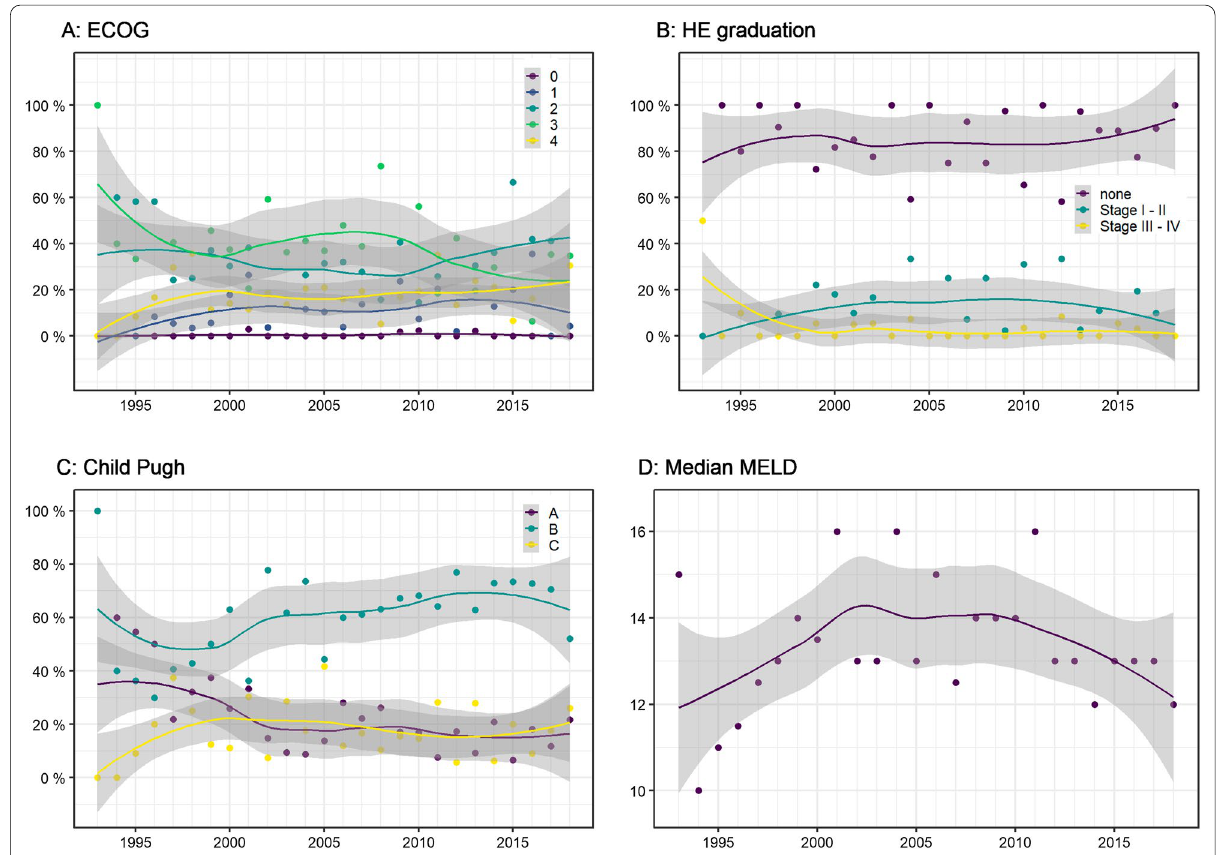
Fig. 4 Clinical and laboratory parameters. a Eastern Cooperative Oncology Group (ECOG) score. Proportion of patients classified according to ECOG score during the observation period. ECOG: 0—asymptomatic, 1—symptomatic but completely ambulatory, 2—symptomatic, < 50% in bed during the day, 3—symptomatic, > 50% in bed, but not bedbound, 4—bedbound, 5—death [45]. b Hepatic encephalopathy before TIPS. Proportion of patients with HE classified according to the West Haven Criteria over the observation period. I: mild symptoms, e.g., loss of sleep and shortened attention span. II: moderate symptoms, e.g., memory loss and slurred speech. III: severe symptoms, e.g., personality changes, confusion, and extreme lethargy. IV: a loss of consciousness and coma [46]. c Child–Pugh score. Child–Pugh score over the observation period. d MELD score. Median MELD score over the observation period. Three patients had a MELD score over 40, all of them with CPS C and ECOG score 3; one of them underwent TIPS in an emergency setting